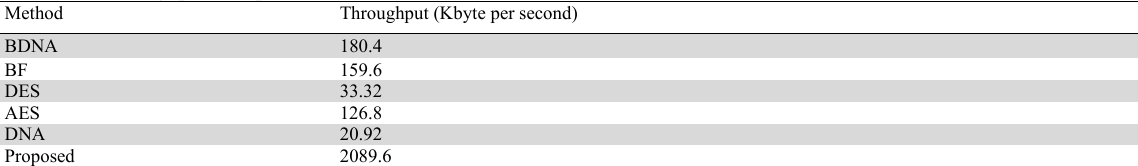
Fig. 20. Block size vs. throughput Compared with other methods, the proposed method improved, as shown in Table 10. Methods of throughput